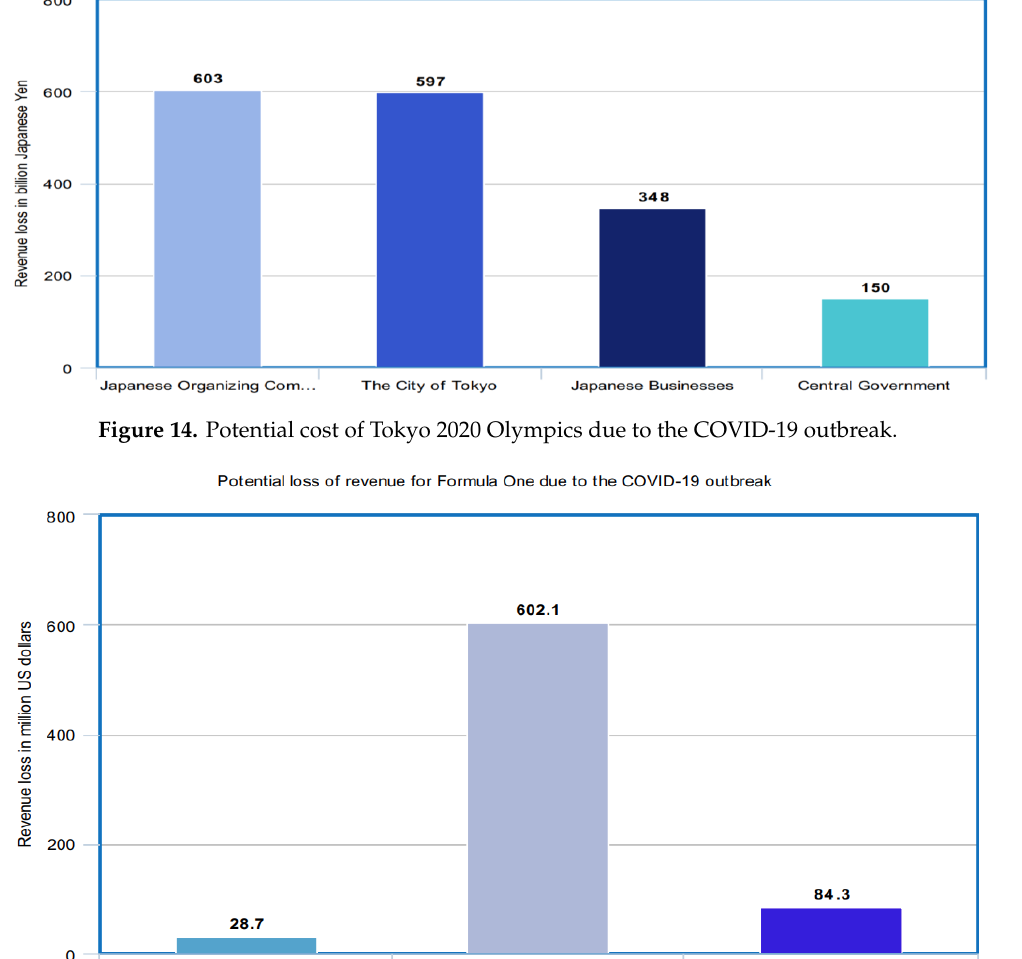
Figure 15. Potential loss of revenue for Formula One due to the COVID-19 outbreak